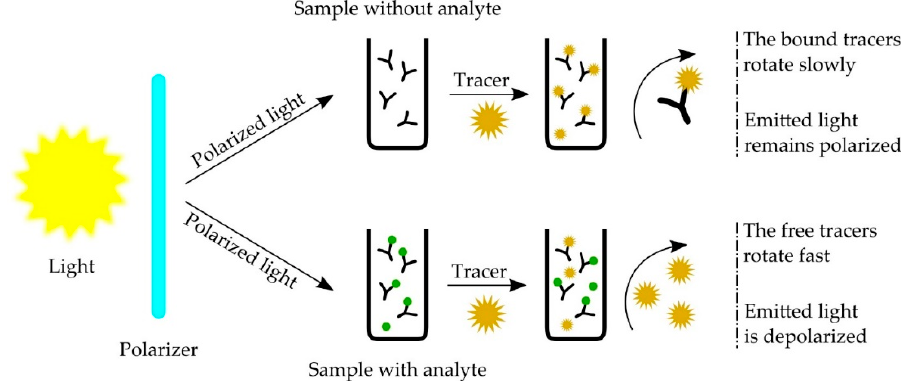
Figure 1. Schematic diagram of fluorescence polarization immunoassay.